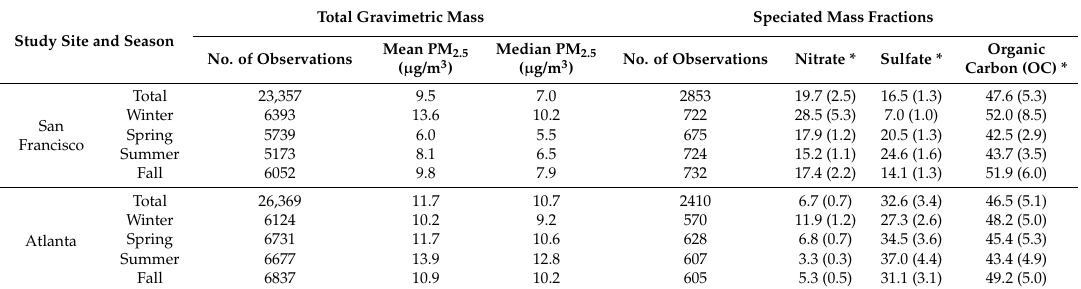
Table 1. Descriptive results for total gravimetric mass and species fractions.